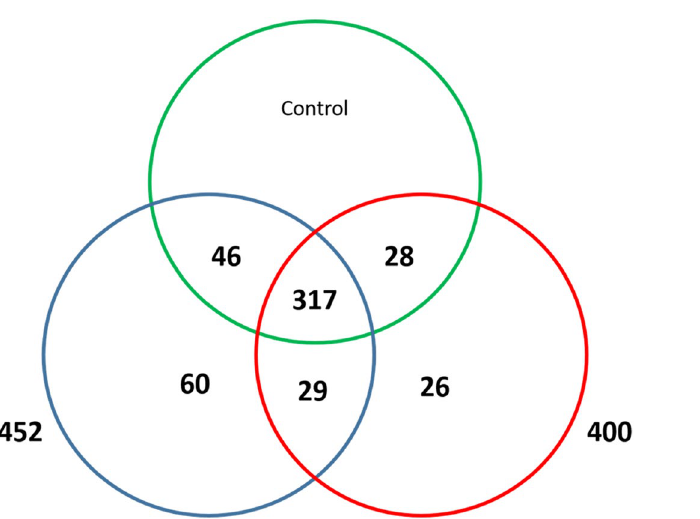
Figure 6. Total number of conserved miRNA families in test groups. Overall. 75, 60 and 26 miRNA families were only detected in Control(green), Test 1 (blue) and Test 2 (red),